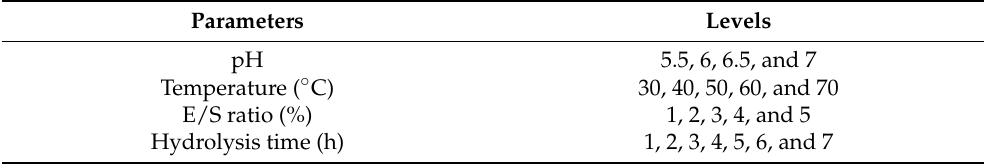
Table 4. The parameters applied to obtain optimal enzymatic hydrolysis conditions to produce protein hydrolysates from bighead carp (Hypophthalmichthys nobilis) using the flavourzyme enzyme.